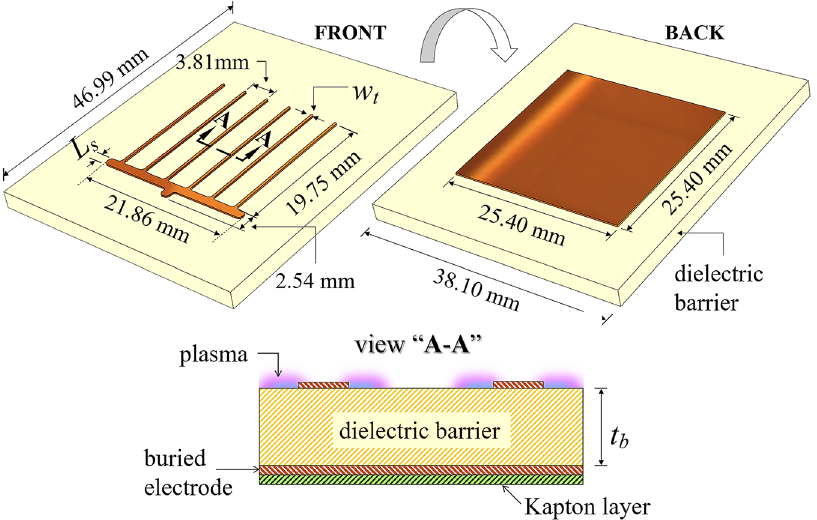
Figure 1. Configuration of the comb shaped DBD reactor. The exposed and buried electrodes are located on the front and back of the reactor, respectively. A cross-sectional view “A-A” shows the formation of plasma on the surface of the dielectric barrier around the edges of the exposed electrode. w t = width of each teeth (0.38 mm); L s = length of the shaft (1.27